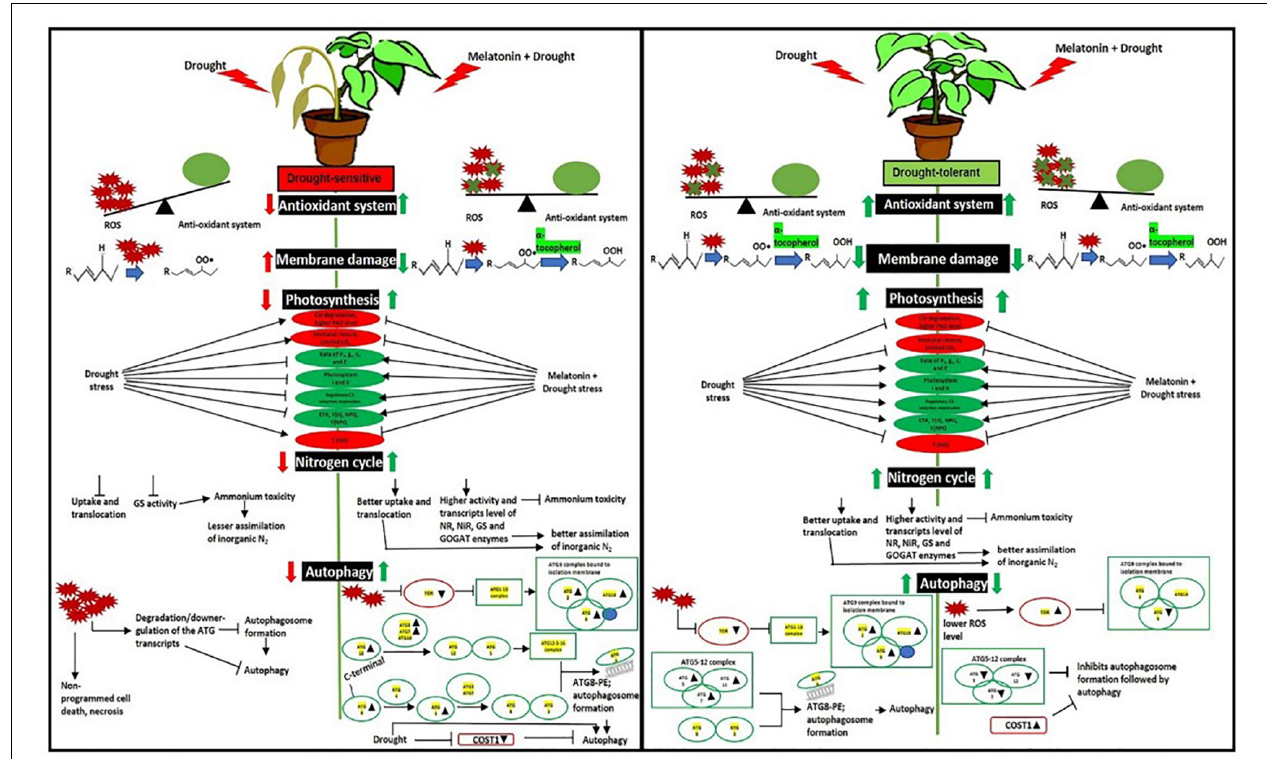
FIGURE 12 | Schematic representation of mechanistic differences of the effects of melatonin priming on drought-tolerant (L-799) and drought-sensitive (Suraj) varieties of upland cotton under drought stress. Improved antioxidant systems, photosynthetic machineries, and nitrogen metabolism substantiate the positive effect of melatonin on L-799 under drought stress. Exogenous melatonin priming did not provide any further beneficial effect on drought tolerant variety possibly due to the higher endogenous melatonin content, which is in itself sufficient for drought tolerance and thus could be turning off the effects of exogenous melatonin due to feedback inhibition. Melatonin priming was found to differentially regulate ROS levels and thus autophagy in drought-sensitive and -tolerant varieties.